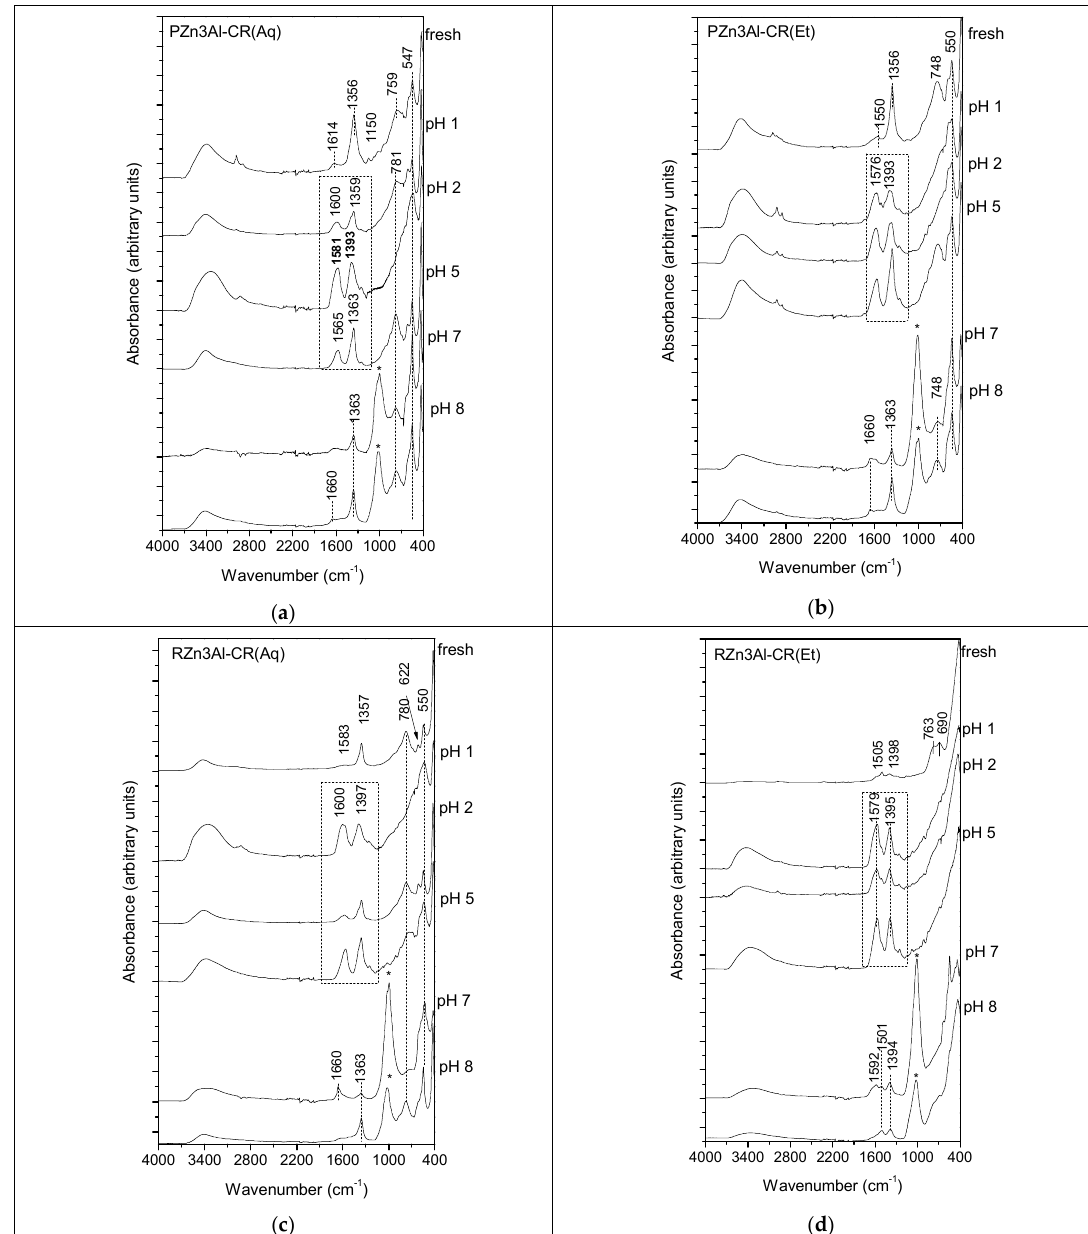
Figure 12. ATR-FTIR spectra of the CR-containing samples after the CR-release tests at different pH values: ( a ) PZn3Al-CR(Aq); ( b ) RZn3Al-CR(Aq); ( c ) PZn3Al-CR(Et); ( d ) RZn3Al-CR(Et).